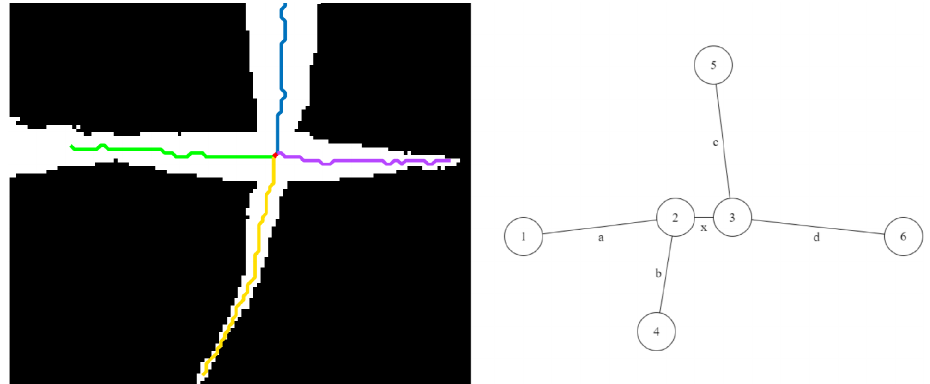
Figure 12. Illustration of crossover: ( left ) skeleton; ( right ) skeleton-graph